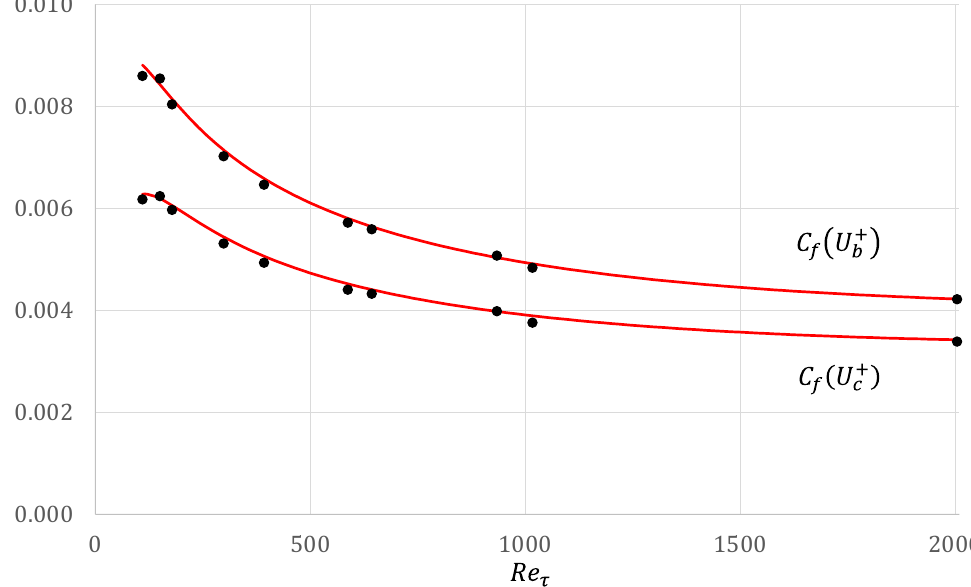
(cid:0) (cid:1) = (cid:0) (cid:1) 2 U b + U b + 2/ and of the skin (cid:0) (cid:1) = (cid:0) (cid:1) 2 U c + U c + 2/ ; • DNS data; and – ITM.